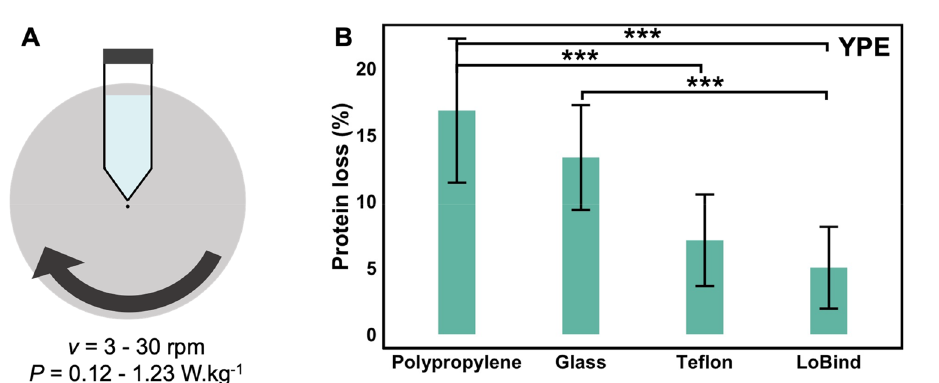
Figure 2. ( A ) Scheme of the experimental setup designed to measure protein loss during agitation of a protein solution with a rotating wheel. The speed ranged from 3 to 30 rpm corresponding to a power of 0.12 to 1.23 W/ kg. Tubes made of PP, glass, TEFLON, LOBIND were used. A conical PP FISHERBRAND tube is represented. ( B ) Protein losses measured after 24 h agitation of YPE cell extract at 6 °C and 3 rpm in each tube. The initial protein concentration was C 0 = 0.1 g/L and filled volume 60%. The error corresponds to the standard deviation for three biological replicates. Significant differences are determined using the Tukey’s “honestly significant difference” test realized from variance analysis (Anova) (*** p -value <